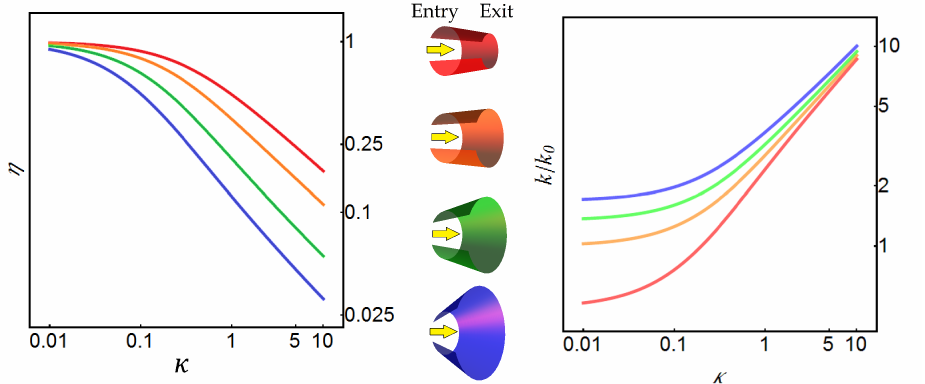
Figure 3. Predictions for the normalized mass transfer coefficient k / k 0 ( left ) and effectiveness factor η ( right ) as a function of the pore geometry, for the four conical pores depicted in the figure using the reduced scheme. See Appendix